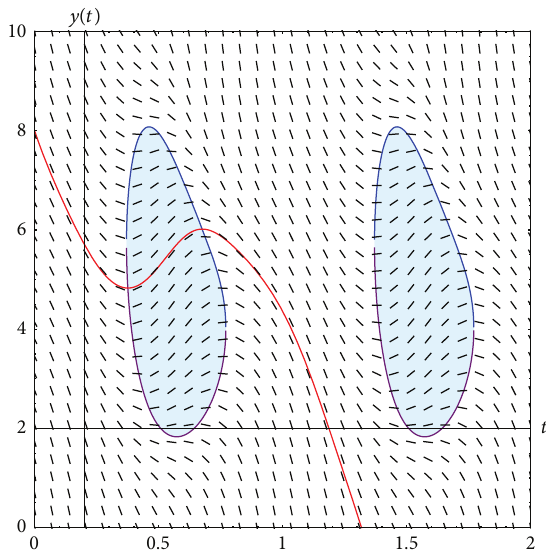
Figure 10: Several solutions to (50) for 𝜎 = 2.395 .